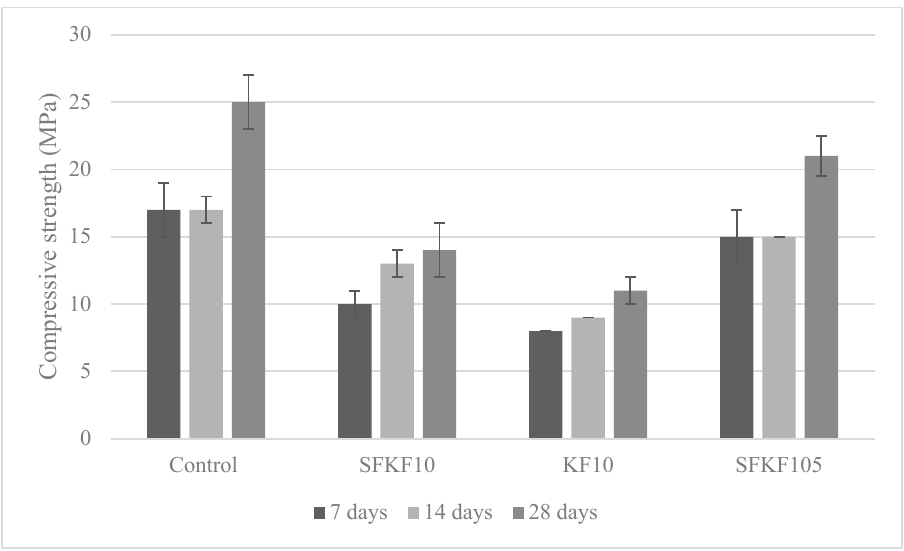
Figure 6. Variation of compressive strength .